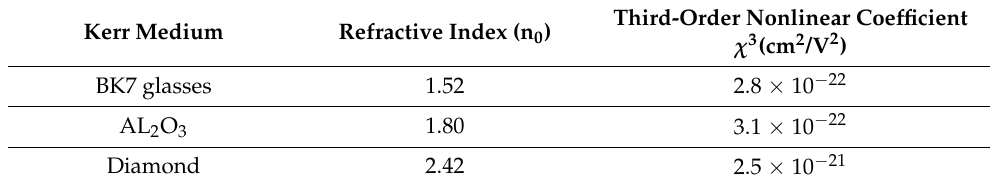
Figure 2. ( a ) Transmittance curves of three Kerr media between 0.6um and 1.2 um. ( b ) Refractive index curves of three Kerr media below 1.2 um. Table 1. Refractive indexes and third-order nonlinear coefficients of three Kerr media at 800 nm.